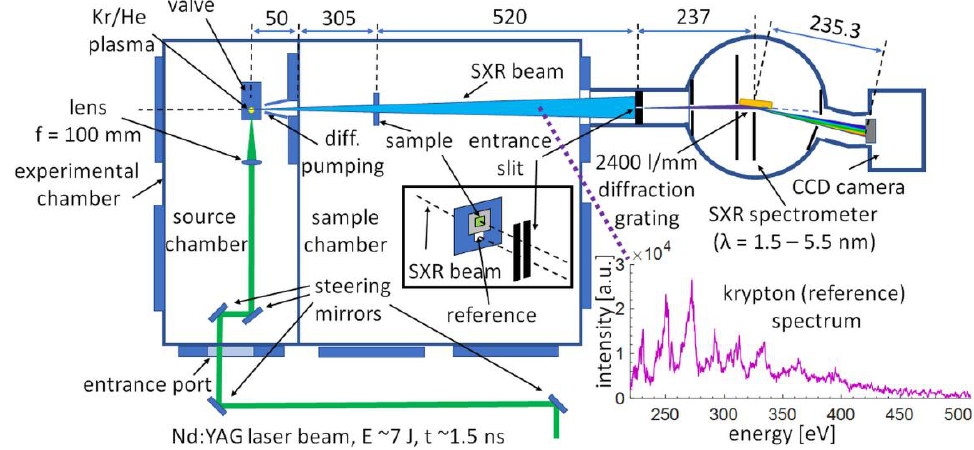
Figure 1. Optical arrangement for single soft X-ray (SXR) pulse experimental near edge soft X-ray fine structure (NEXAFS) system employing laser plasma source based on a double stream gas puff target.